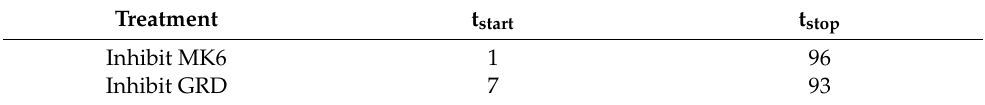
Table 4. The two intervention treatments course starting from SS2 results in a 31% return to health. Treatment t